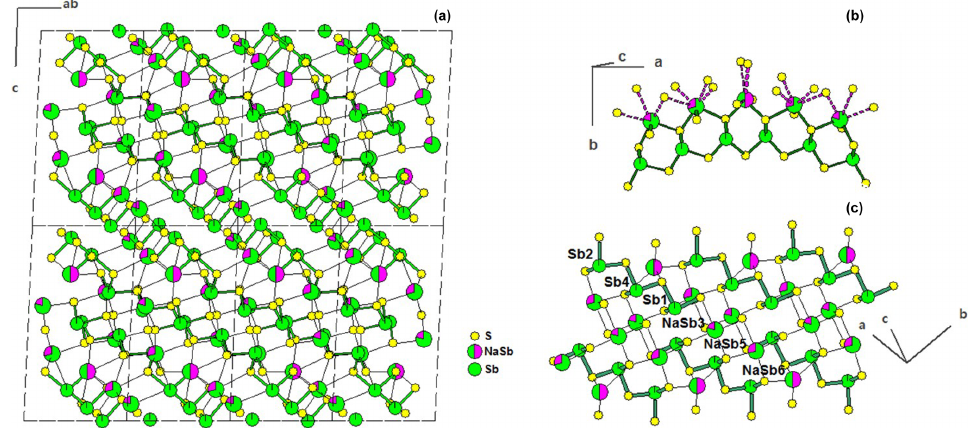
Figure 9. Proposed distribution of Na / Sb mixed sites in the structure of Pb-free fülöppite of Swinnea et al. (1985). (a) Projection along [110]. (b) Polymerization of cations according to short Me –S bonds. (c) Organization of the SnS-type ribbon. Pink sectors: Na fraction in mixed (Sb, Na)